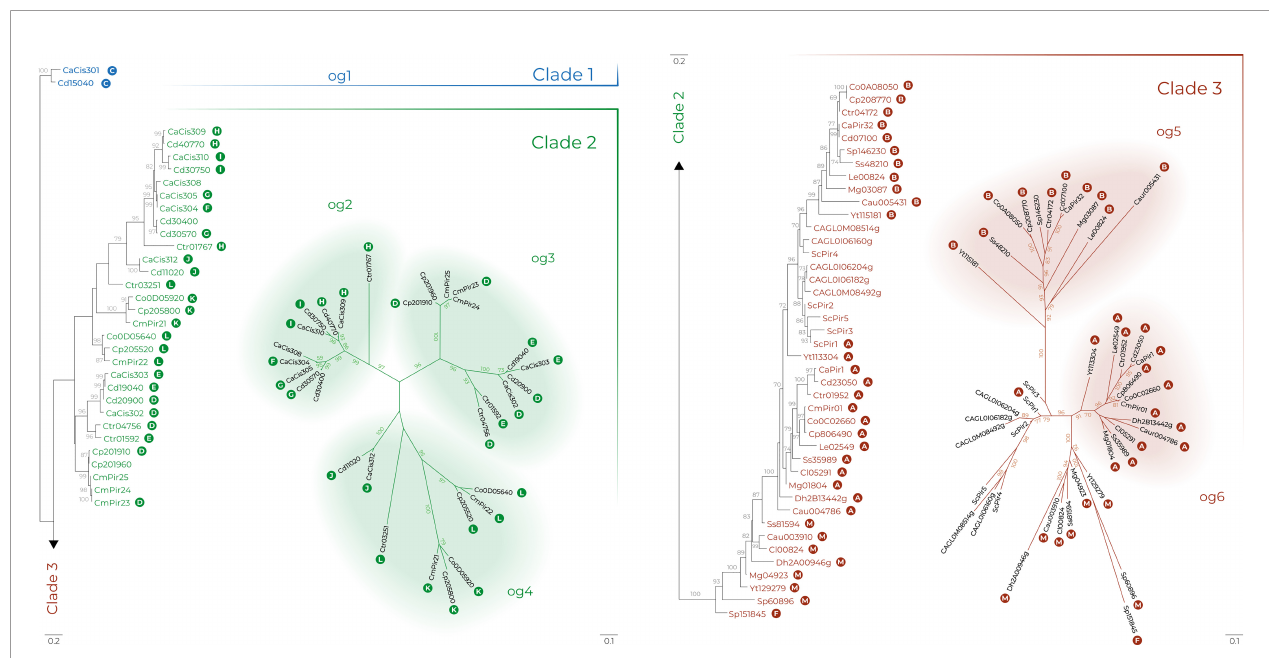
FIGURE 5 | Pir family phylogeny in Candida albicans (Ca), C. auris (Cau), C. dubliniensis (Cd), Candida glabrata (CAGL), C. metapsilosis (Cm), C. orthopsilosis (Co), C. parapsilosis (Cp), C. tropicalis (Ctr), Clavispora lusitaniae (Cl), Debaryomyes hansenii (Dh), Loddermyces elongisporus (Le), Meyerozyma guilliermondii (Mg), Saccharomyces cerevisiae (Sc), Scheffersomyces stipitis (Ss), Spathaspora passalidarum (Sp) and Yamadazyma tenuis (Yt). The best-scoring maximum likelihood tree is shown with maximum likelihood bootstrap values appended to the nodes; only support values higher than 70% were shown. Trees in radial layout (right) show phylogenies of clades 2 and 3 with tentative orthologous groups (og) designated by a colored background. White letters in colored circles indicate Candida Gene Order Browser Ortholog Groups (OG) as designated in Supplementary Table S3 . Scale bars represent substitutions per site with different scale bars presented for each tree layout (left and